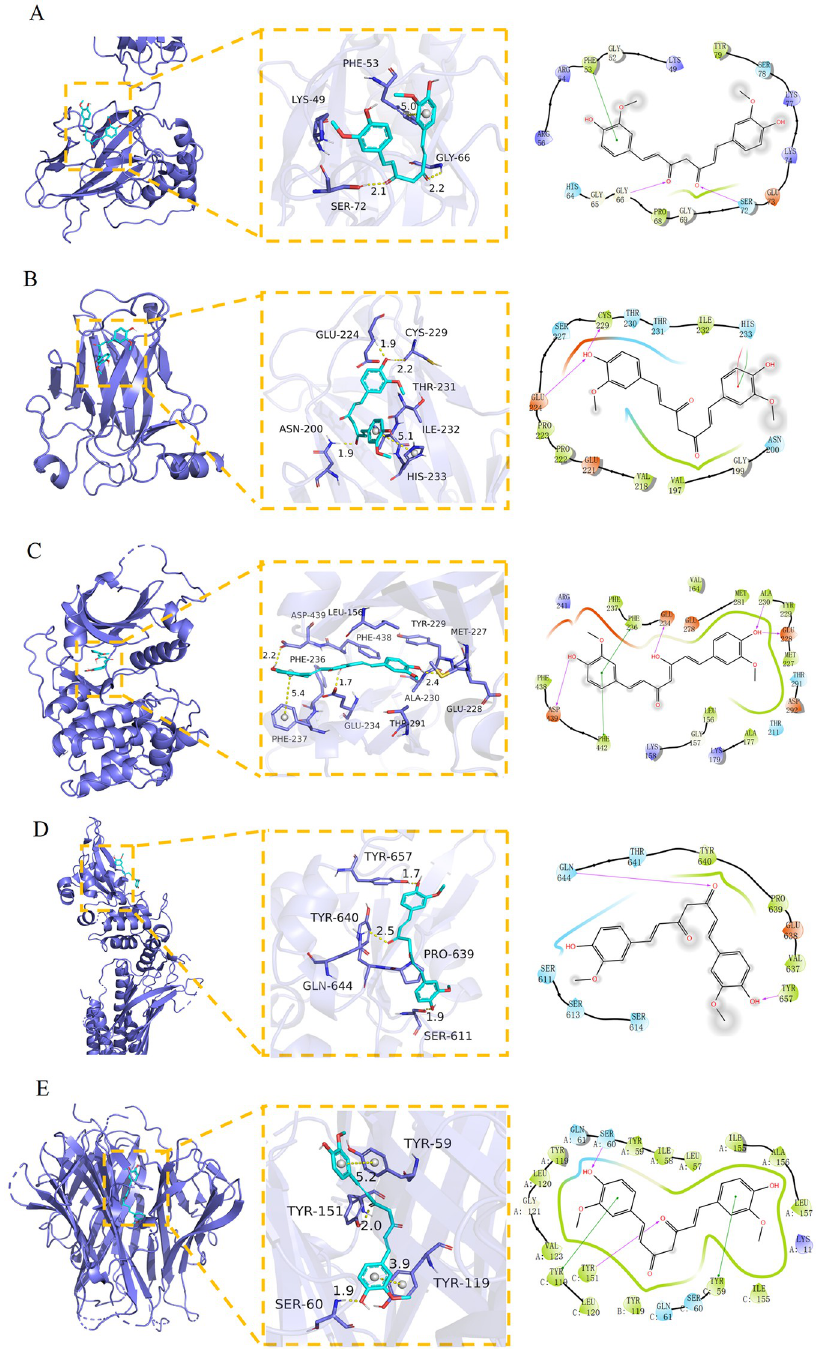
Fig 6. The binding mode of curcumin and 5 Targets. (A) NF- κ B–curcumin. (B) TP53–curcumin. (C) AKT1– curcumin. (D) STAT3–curcumin. (E) TNF-curcumin. Yellow dash represents hydrogen bond distance or π -stacking.